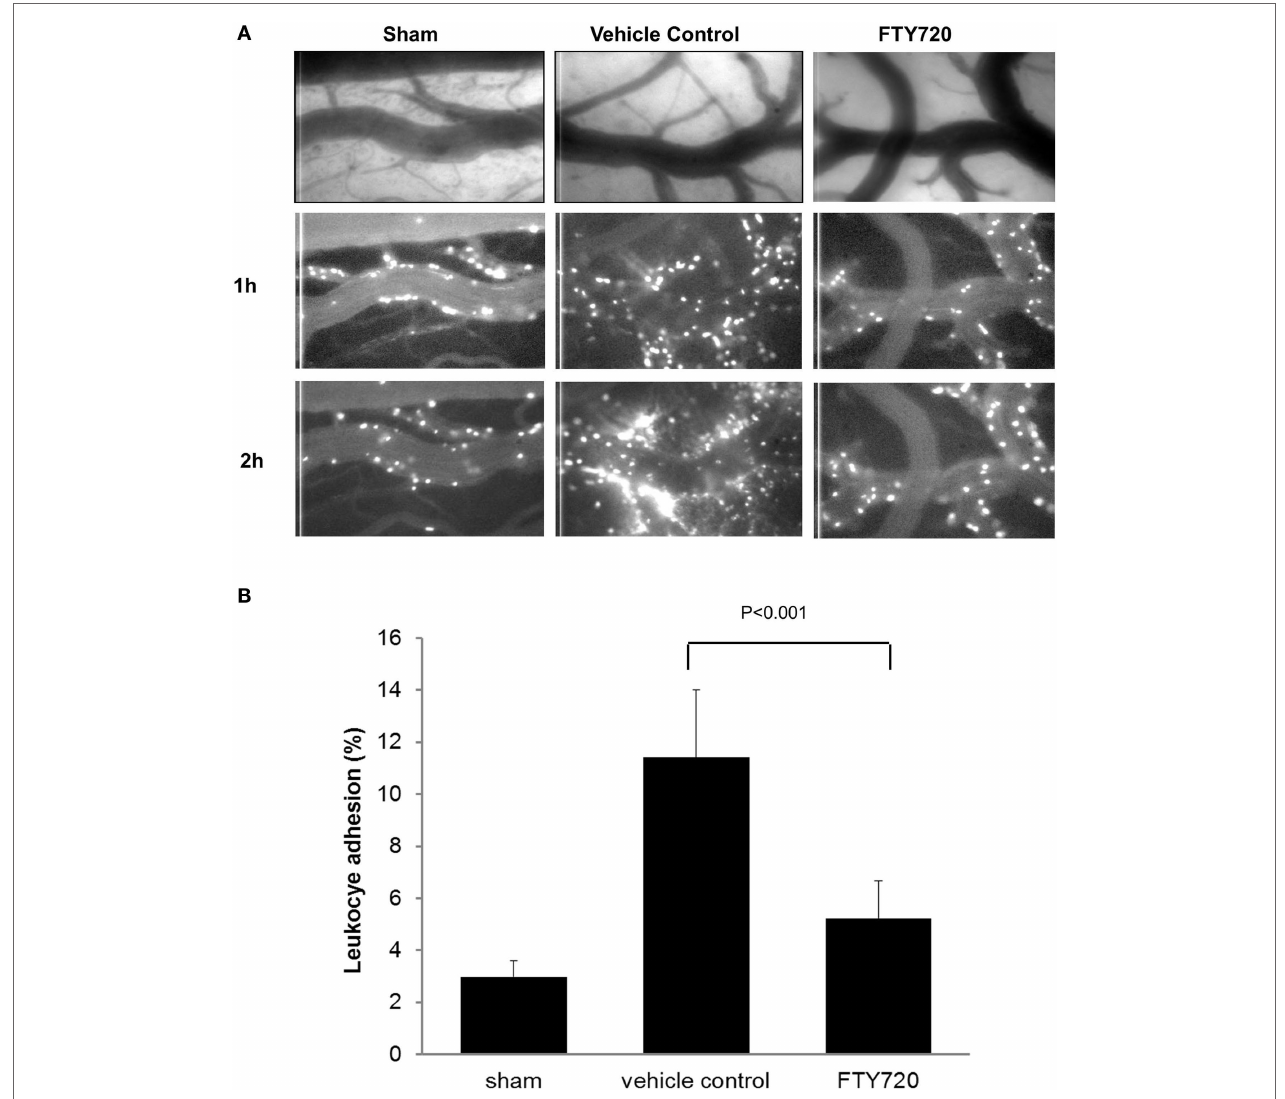
FiGUre 3 | assessment of neuroinflammation after cerebral ischemia reperfusion . Male adult Sprague-Dawley rats were subjected to middle cerebral artery occlusion (MCAo) for 60 min followed by reperfusion. Three hours after reperfusion, animals were treated with vehicle or 0.5 mg/kg FTY720 intraperitoneally. Leukocyte adhesion to pial venules was determined 24 h after reperfusion by intravital microscopy using rhodamine 6G-labeled autologous leukocyte as previously described (46). (a) Representative pictures of the vessel anatomy and the trafficking of leukocytes 1 and 2 h after leukocyte labeling with Ro6G in sham, vehicle control, and FTY720-treated animals. (B) Quantification of leukocyte adhesion, expressed as the percentage of the vessel area occupied by adherent leukocytes measured 1 h after leukocyte labeling. The MCAo-vehicle group demonstrated a significant increase in vascular leukocyte adhesion at 24 h post reperfusion compared to sham. The treatment with FTY720 decreased the adherence of leukocytes to pial vessels by almost 60%. Significance determined using an unpaired t -test. Means ± SD ( n =